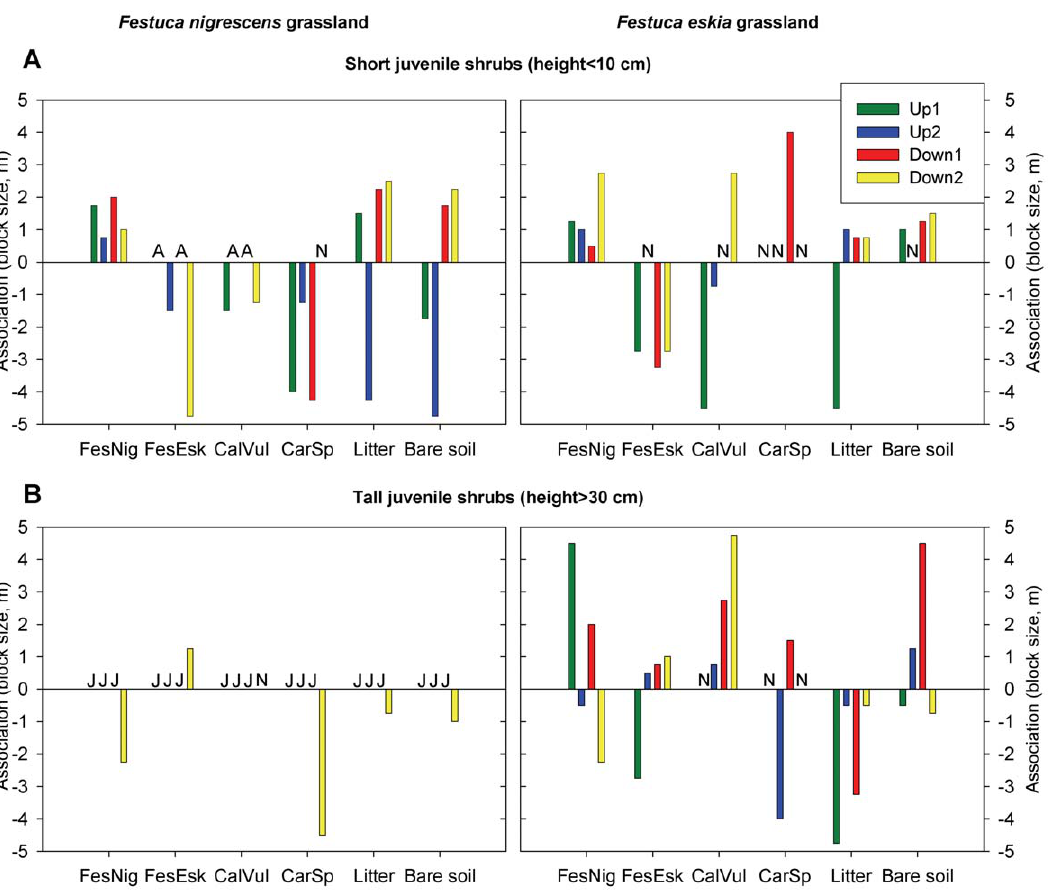
Figure 4. Scales of positive and negative associations between each cover type and a) short juvenile Cytisus (height , 10 cm) and b) tall juvenile Cytisus (height . 30 cm) in F.nigrescens or F.eskia grasslands. Cover types: FesNig = Festuca nigrescens ; FesEsk = Festuca eskia ; CalVul = Calluna vulgaris ; CarSp = Carex sp. ( A =cover type absent in the plot; J =juvenile Cytisus with height . 30 cm absent in the plot; N =association is non-significant below 5 m). All the scales of association except those indicated ( N ) are significant ( p , 0.05) based on randomization tests used to build a null covariance model and the associated 95% confidence intervals.